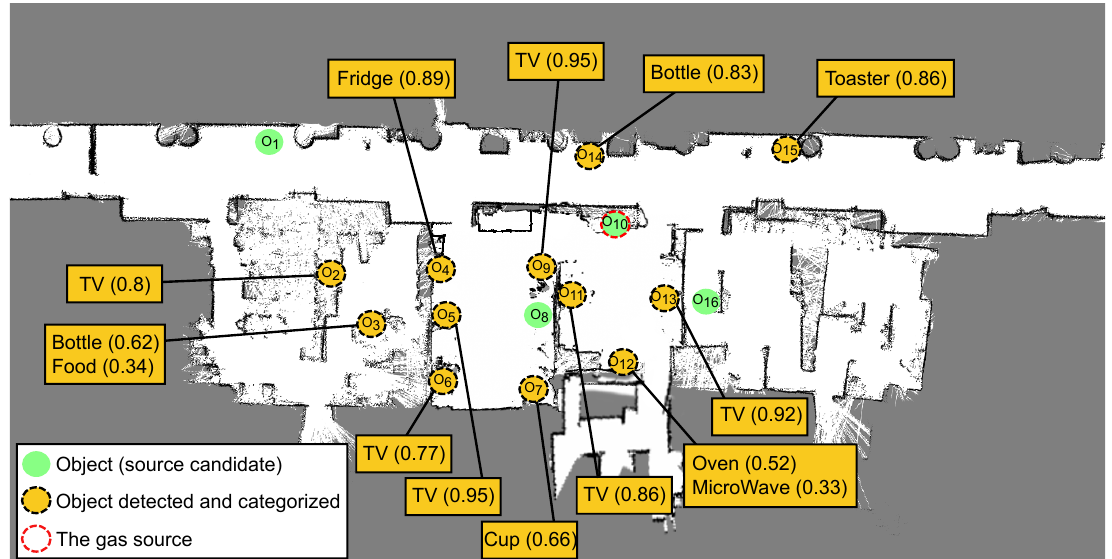
Figure 4. Occupancy grid map of the environment with detailed location of the objects present on it and their respective categorizations as outputted by the vision-based object recognition system. When the source search is triggered, only 12 out of 16 potential candidates have been detected, not including in this set the gas